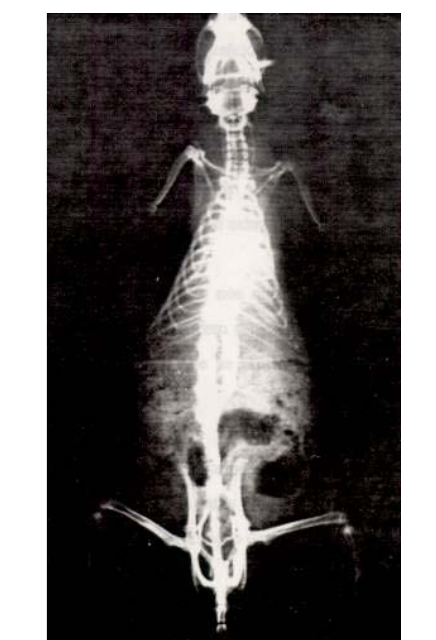
FIGURA 5 - Cavografia após ligadura da veia íleo-lombares.